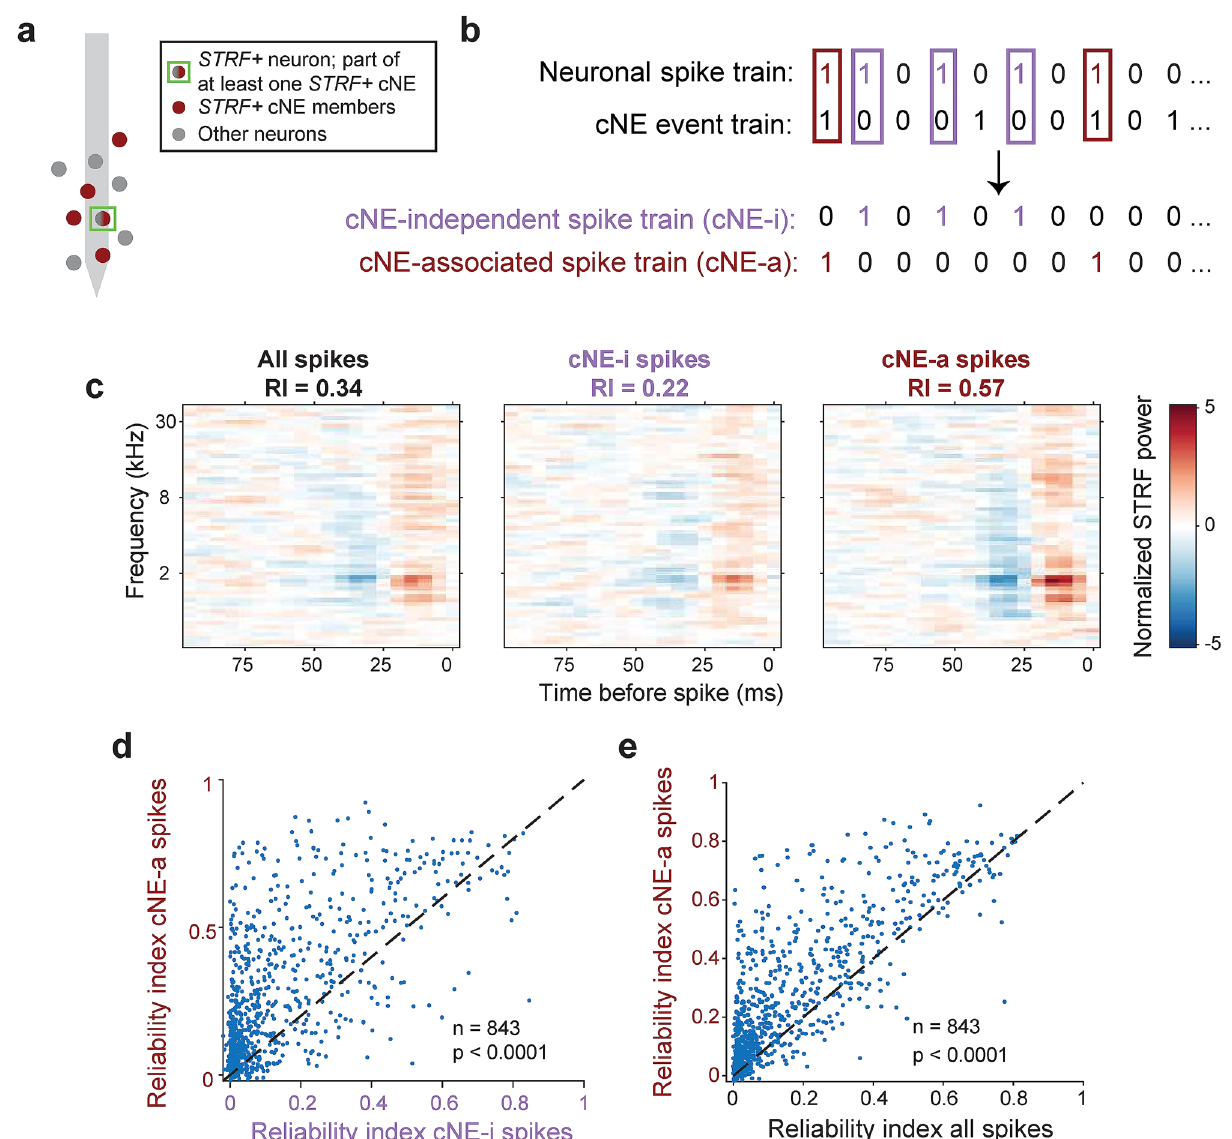
Figure 6. cNE-associated (cNE-a) spikes are more stimulus-dependent than cNE-independent (cNE-i) spikes. ( a ) Schematic of a sample STRF + neuron (green square) relative to the electrode (light gray) that is part of at least one STRF + cNE. This neuron is part red and part gray to illustrate the splitting of its spikes into smaller subsets. ( b ) Illustration of a neuronal spike train split into cNE-i and cNE-a subset spike trains based on coincident activity with cNE events. ( c ) STRFs for the sample neuron’s entire spike train (all spikes), cNE-i and cNE-a subset spike trains. Spike trains were sub-sampled to match the number of spikes across all three types of spike trains. STRF power was also normalized across all three STRFs. The cNE-a STRF had the highest power, followed by the STRF for all spikes and the cNE-i STRF. ( d ) Across the entire cNE population, cNE-a spikes had higher RI than cNE-i spikes (≈ 80% above black dashed unity line). ( e ) cNE-a spikes also had higher RI than all spikes (≈ 79% above black dashed unity line). ( d , e ) Paired